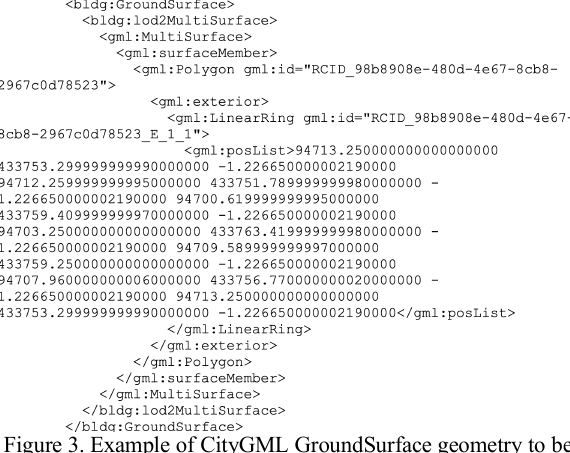
Figure 3. Example of CityGML GroundSurface geometry to be converted to IFC